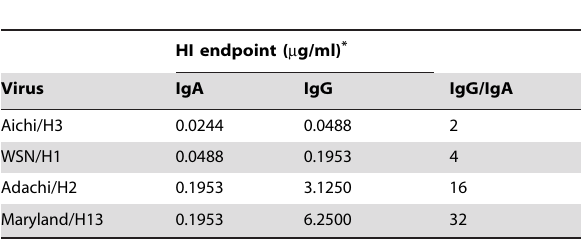
Table 2. Comparison of HI activities of S139/1 IgA and IgG